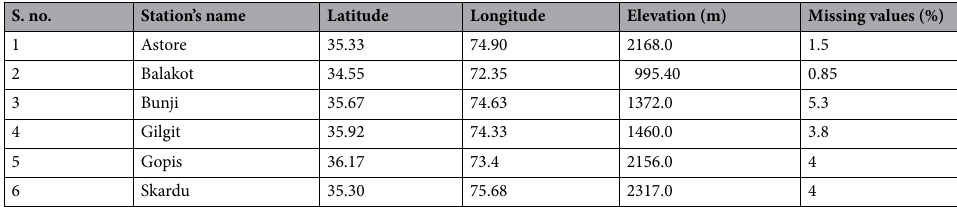
Table 1. Brief information is presented about the stations from which the climate data is used for hydrological projections in the UIB. The total number of observations is 5479 for the duration of 1990–2004 including missing